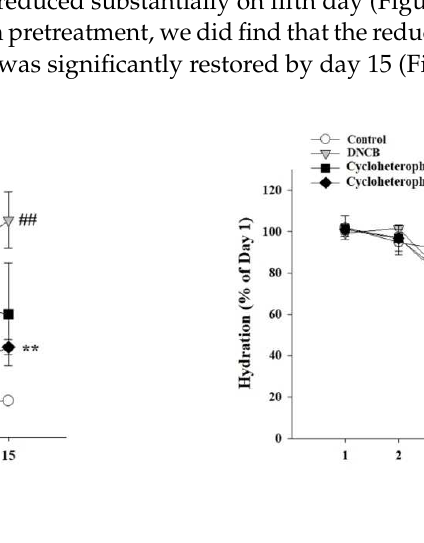
Figure 5. The effect of cycloheterophyllin on DNCB-induced inflammatory response to changes in skin appearance in mice. ( Left panel) shows the effect of the skin changes on the dorsal skin. ( Middle panel) shows the inhibitory effect of the inflammatory response on the ear. ( Right panel) shows statistical results of ear inflammation thickness. On the first day, 1% DNCB was administered to the dorsal skin. Then, 0.5% DNCB was administered on the 8th day, the 11th day, and the 14th day to induce skin inflammation. The dorsal skin was given 100 µ L DNCB and the ear was given 20 µ L DNCB. ## p < 0.01 compared to untreated conditions; * p < 0.05 compared to DNCB-induced group.